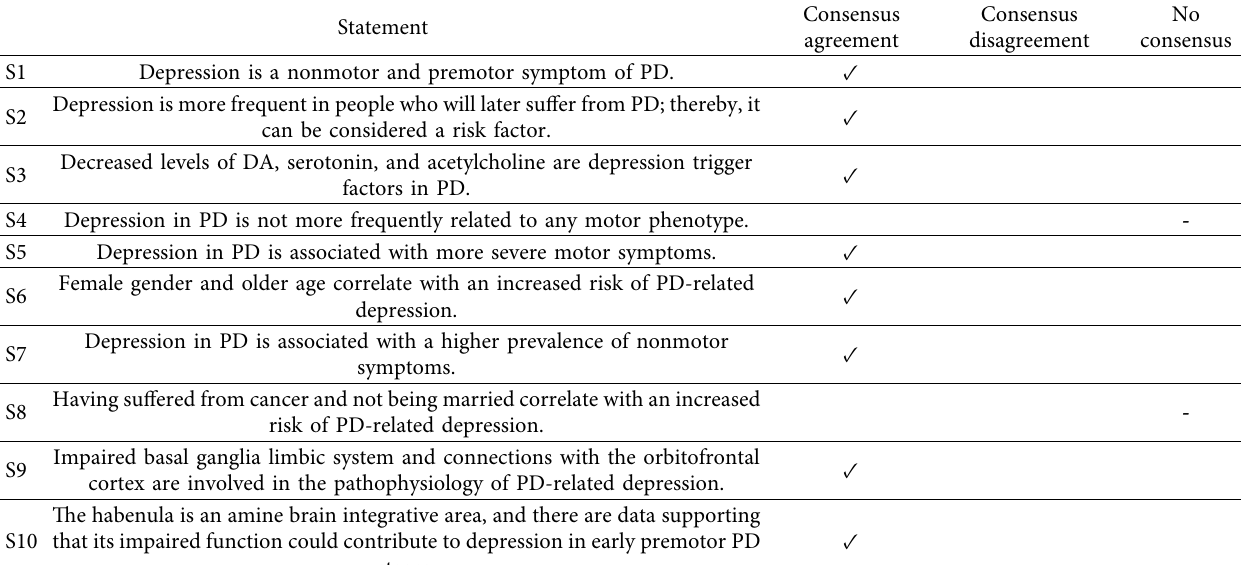
Figure 1: Overall results of the Delphi study: degree of consensus, statement agreement, and disagreement. N � 49 items. Table 1: Section I: aetiology and risk factors for depression in PD